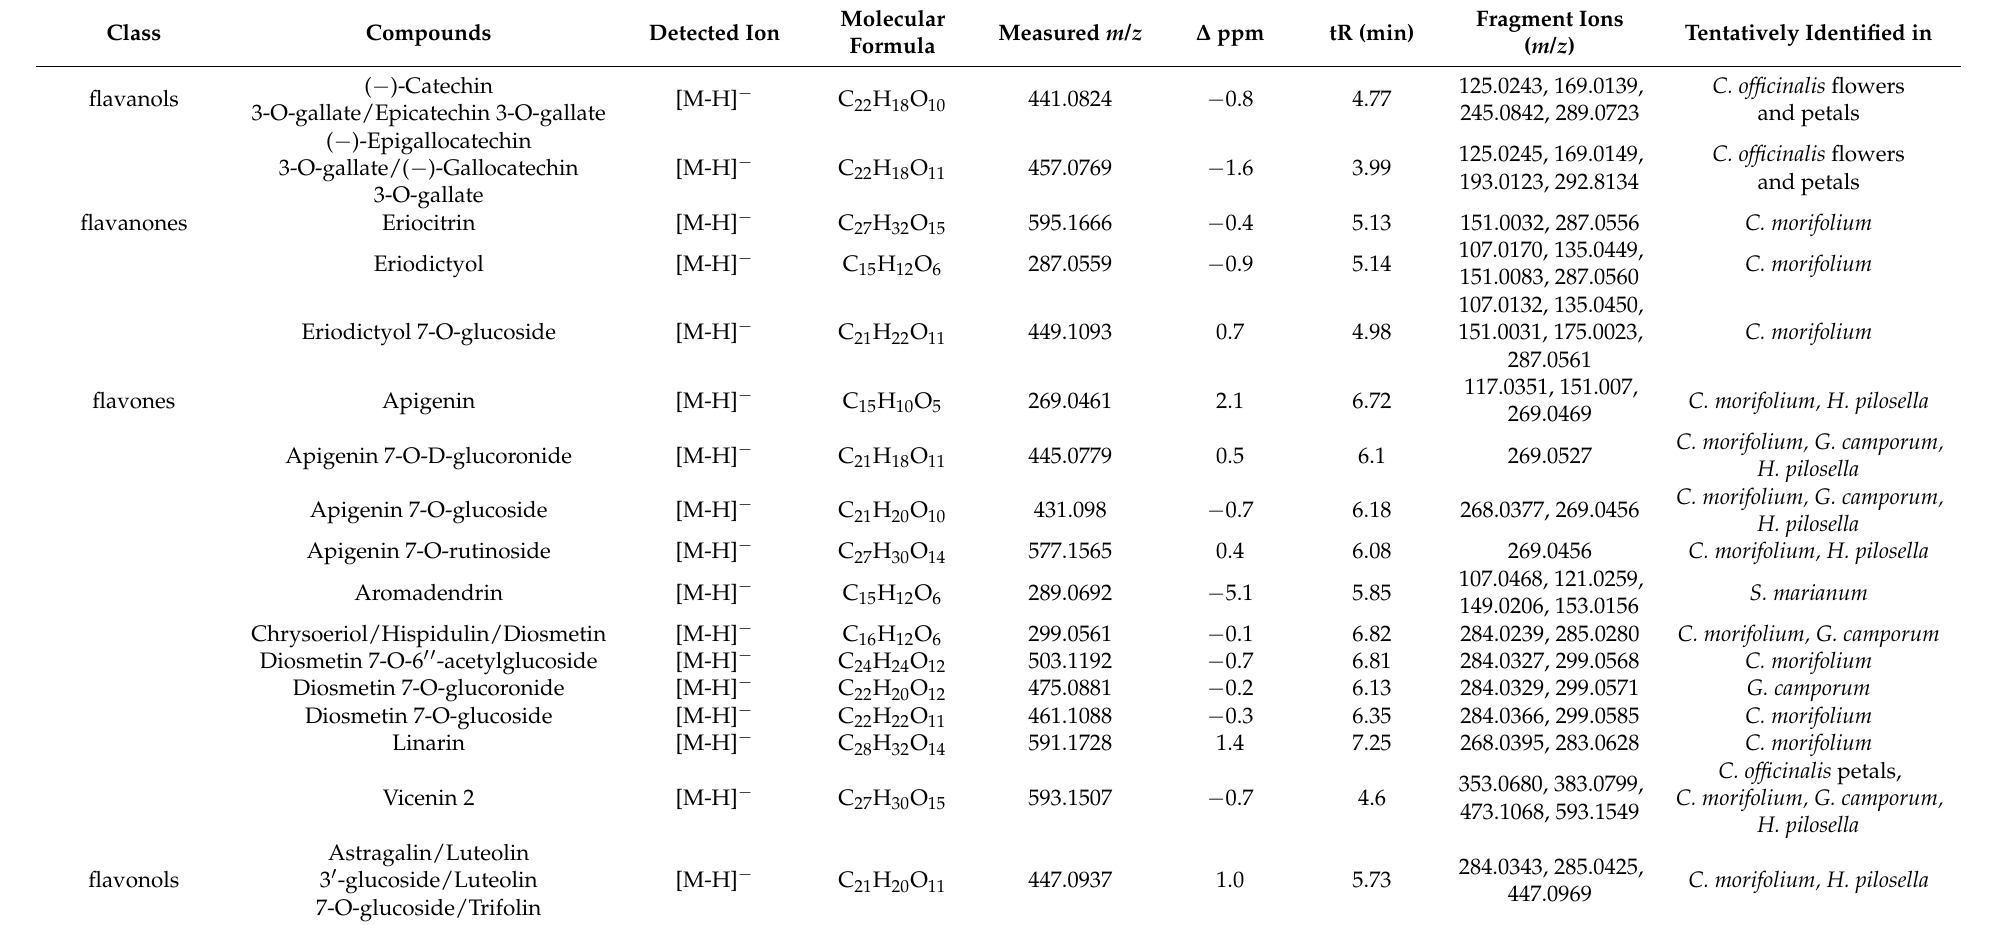
Table 3. Proposed phytochemicals contained in the selected aqueous extracts through metabolomic suspect screening. All the proposed compounds are identified in a level 2